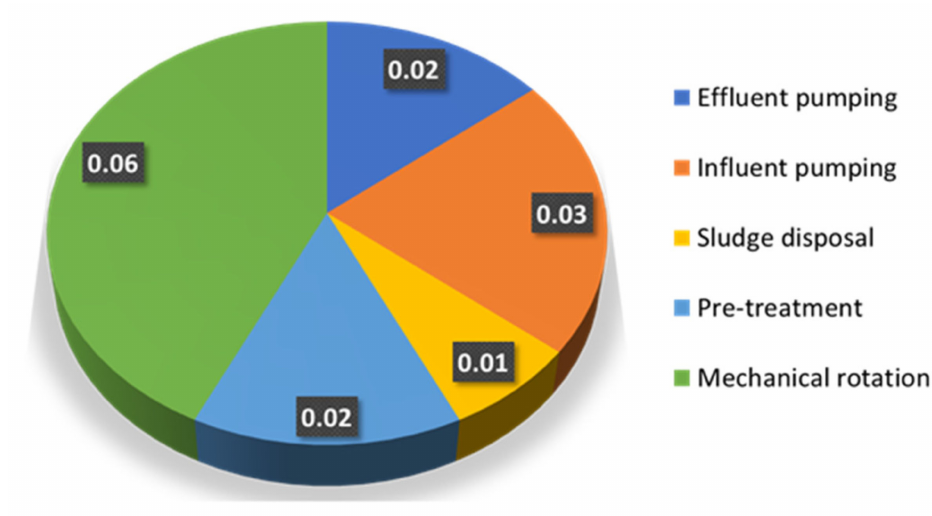
Figure 7. Specific energy demands of the RBC